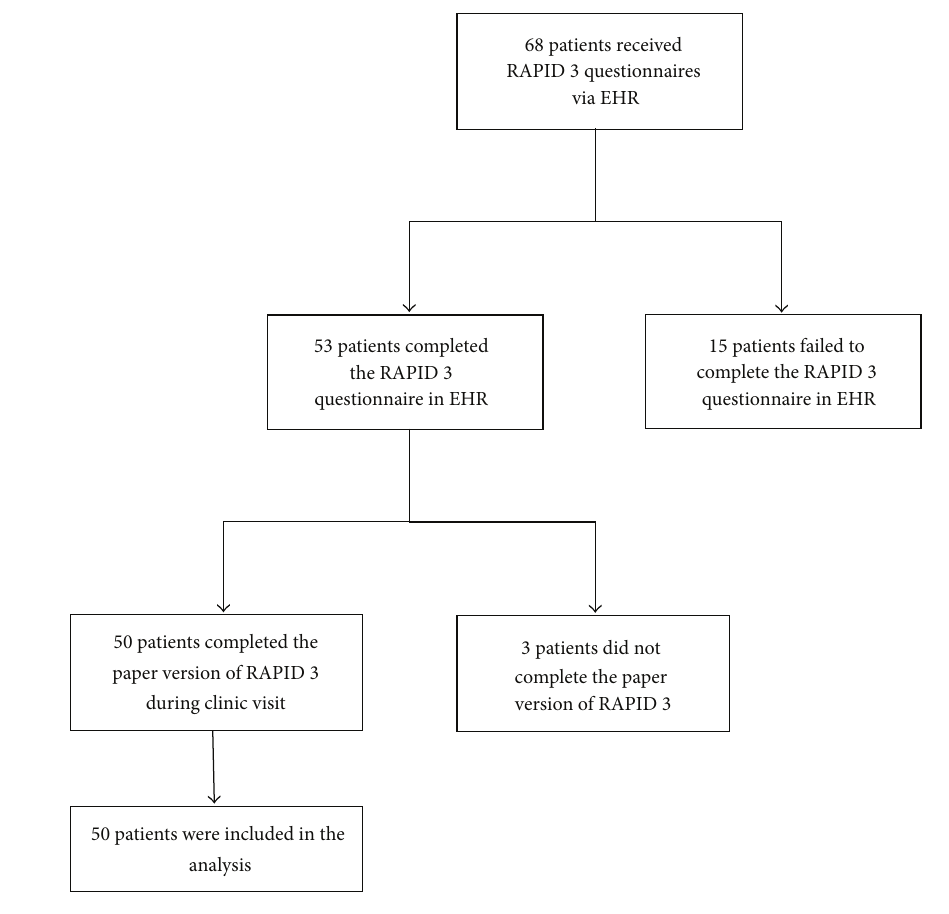
Figure 1: Flowchart of patient recruitment.